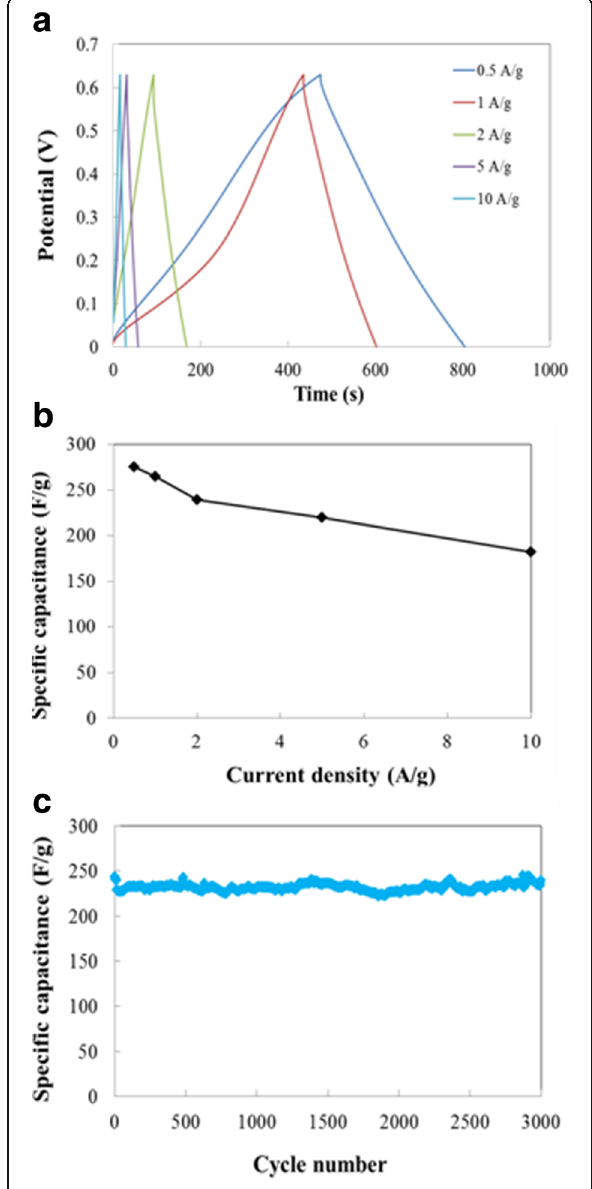
Fig. 5 a Charge – discharge curves at the current density between 0.5 and 10 A/g, b corresponding specific capacitance, and c cycling performance of 2D VO 2 microarrays at 1